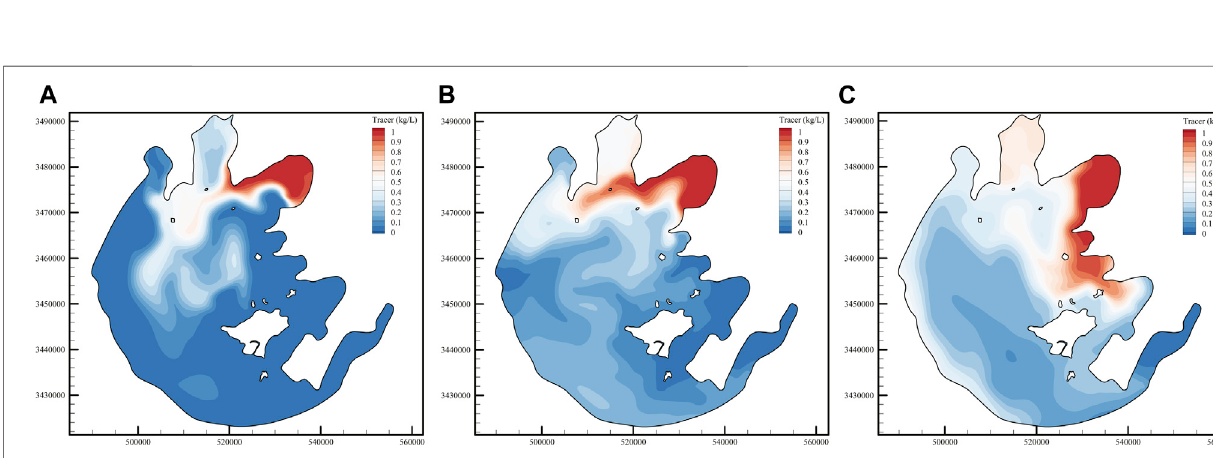
Frontiers in Environmental Science |